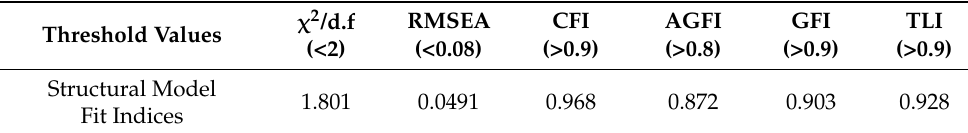
Table 6. Measurement